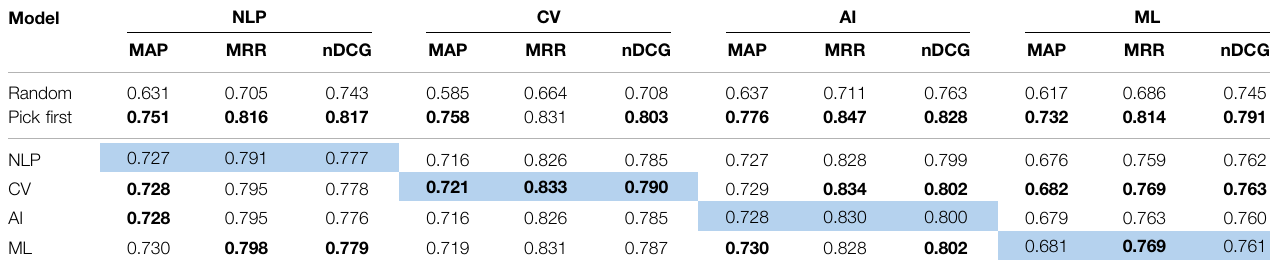
TABLE 5 | Performances of our baselines (random, pick fi rst) against SciBERT models trained on different CS domains (NLP, CV, AI, ML) evaluated on CS domains. We report Mean Average Precision (MAP), Mean Reciprocal Rank (MRR) and Normalized Discounted Cumulative Gain (nDCG). We indicate the best baseline and model performances in bold, and the in-domain setup in light